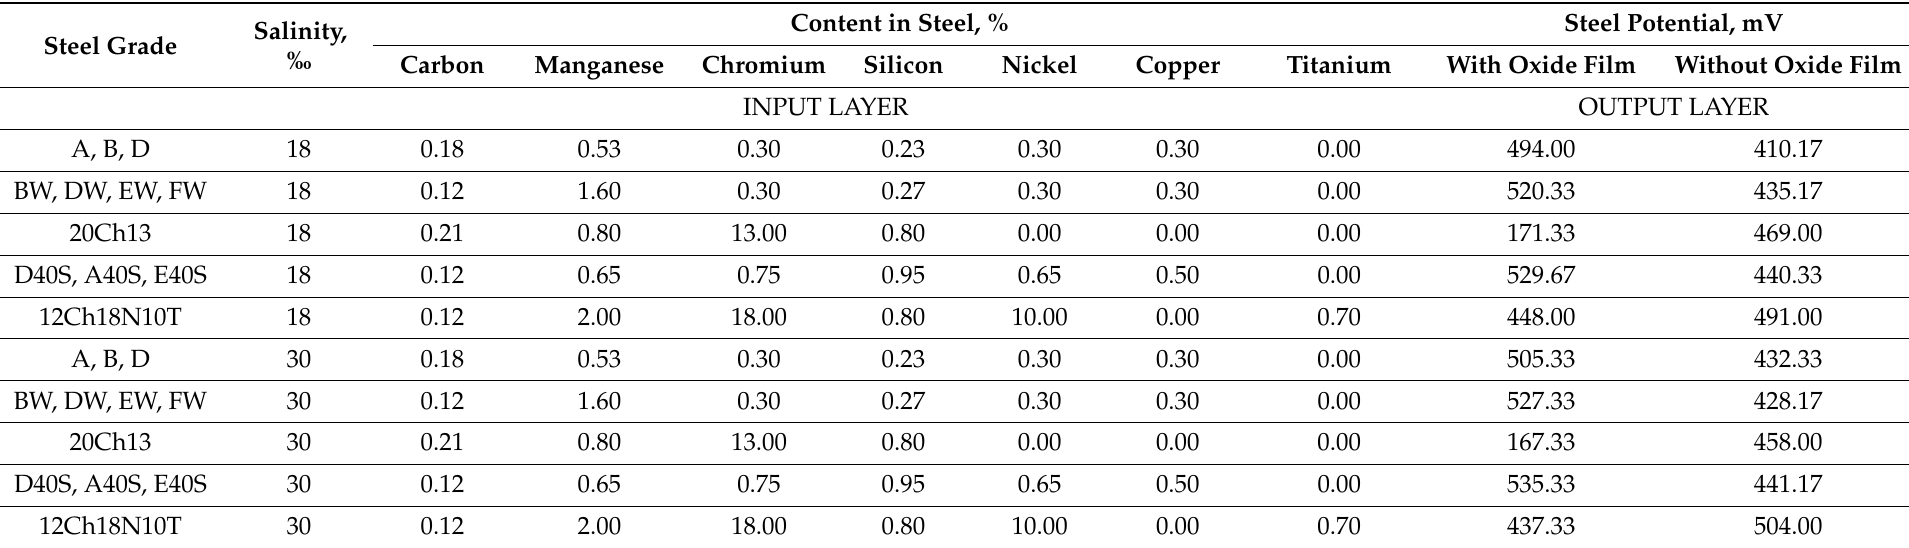
Table 1. Sample for training a neural